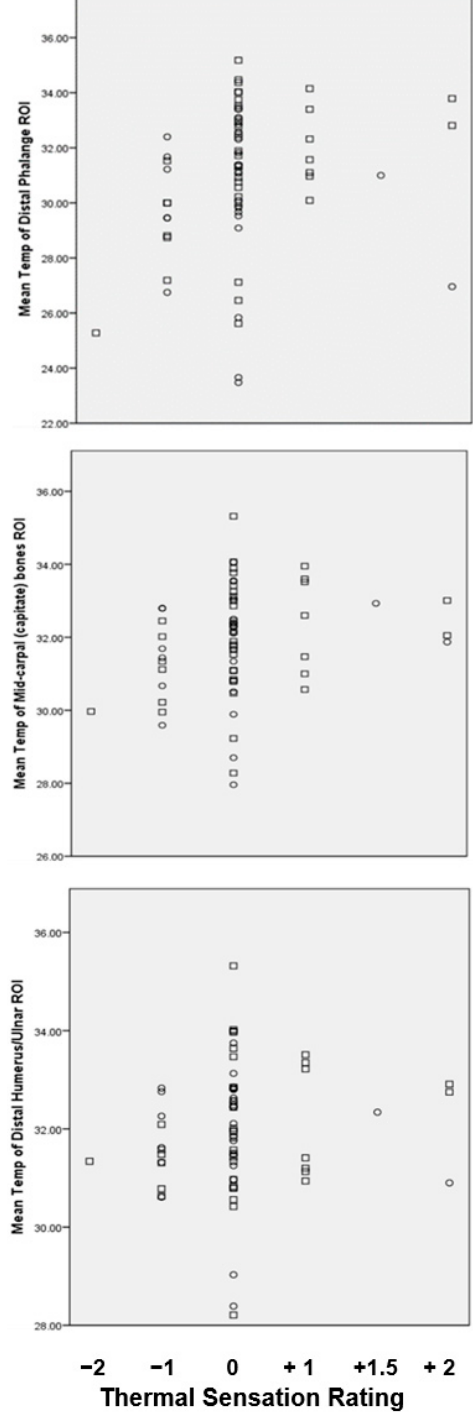
Figure 6. Mean extremity temperature values at three ROIs; distal phalange T DP (upper panel); capitate bones, T Cap (middle); distal humerus, T DH (lower) by group and TS rating. dementia (O), no dementia ( □ ) for each reported thermal sensation rating.